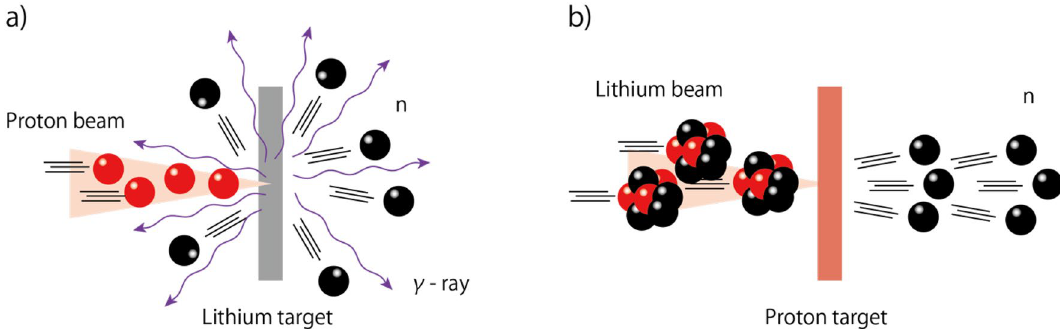
Figure 1. Illustration of neutron production angle for proton versus lithium driver beam (drawn using Adobe illustrator CS5, 15.1.0, https:// www. adobe. com/ produ cts/ illus trator. html). ( a ) Neutrons can be ejected in any direction by this reaction, since the driver proton impinges on a much heavier lithium target atom. ( b ) Conversely, if a lithium-ion driver bombards a hydrogen-rich target, neutrons are generated within a narrow cone in a forward direction, due to the large center of mass velocity of the